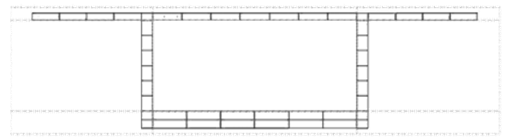
Figure 5. Element mesh in the